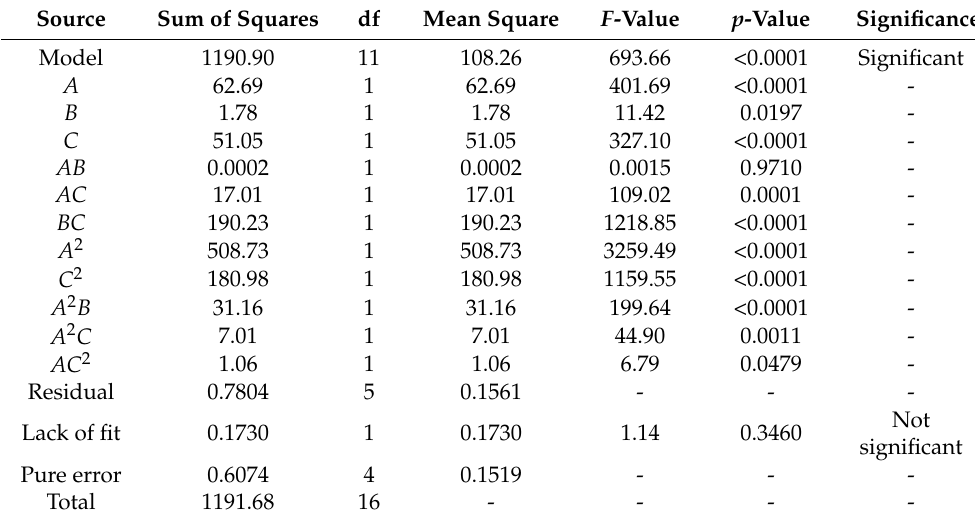
Table 4. ANOVA analysis of the regression equation of additive manufacturing (AM) synthesis score (ANOVA represents the Analysis of